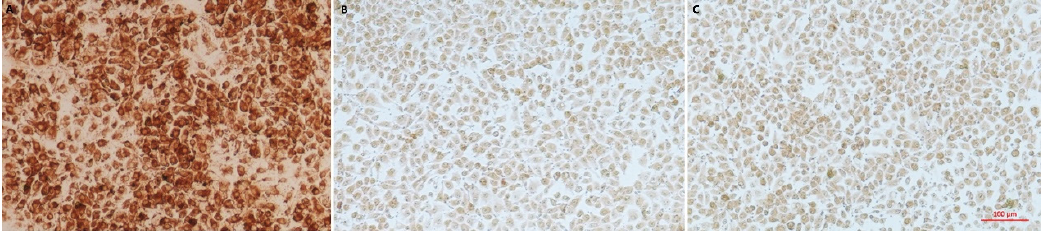
Figure 2. Identification of the virus isolate with immunoperoxidase monolayer assay (IPMA). ( A ) The isolate; ( B ) Negative serum against PCV2; ( C ) Blank control.